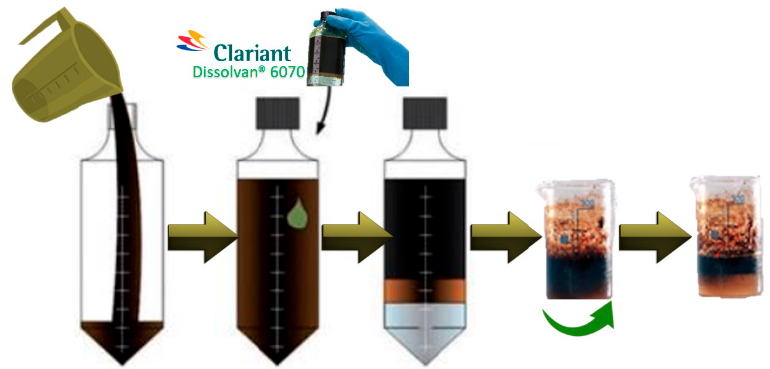
Figure 14. Diagram of determining the effectiveness of the Dissolvan 6070 demulsifier.